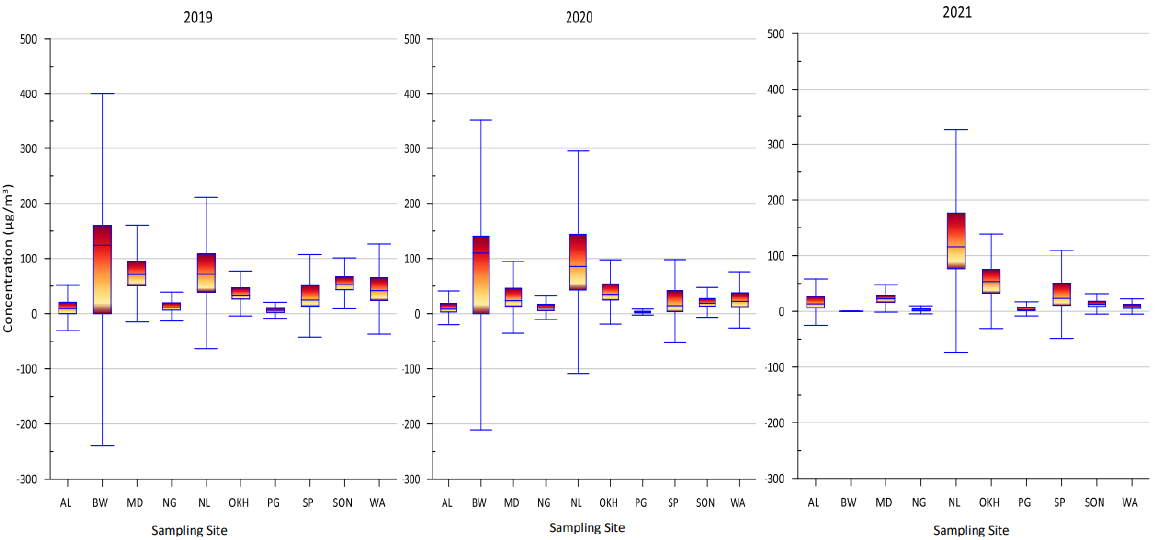
Figure 2. Box plot for TVOCs for different monitoring stations in Delhi for the years 2019, 2020, and 2021 .